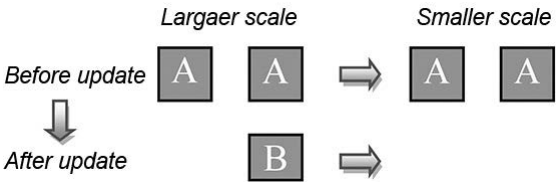
Fig. 3. Cases of deleting a feature